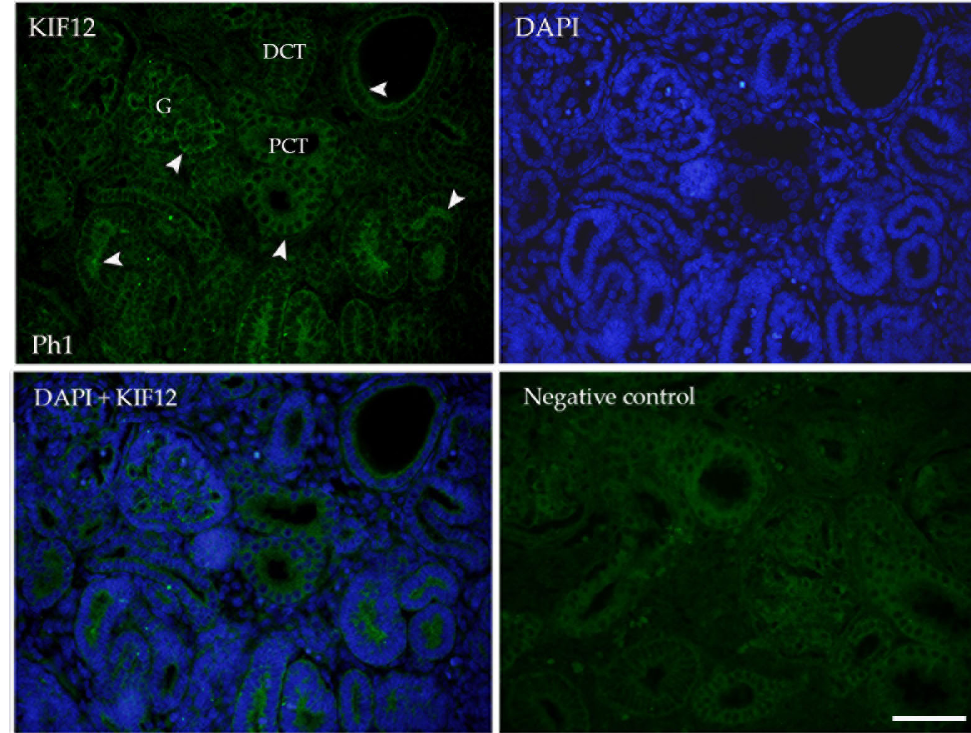
Figure 6. Immunofluorescence staining of human fetal kidneys (Ph1) with the KIF12 (green) and DAPI nuclear staining. Expression of KIF12 (arrows) is found in glomeruli (G), proximal convoluted tubules (PCT), and distal convoluted tubules (DCT), while the surrounding mesenchyme is negative. Scale bar is 50 µ m.